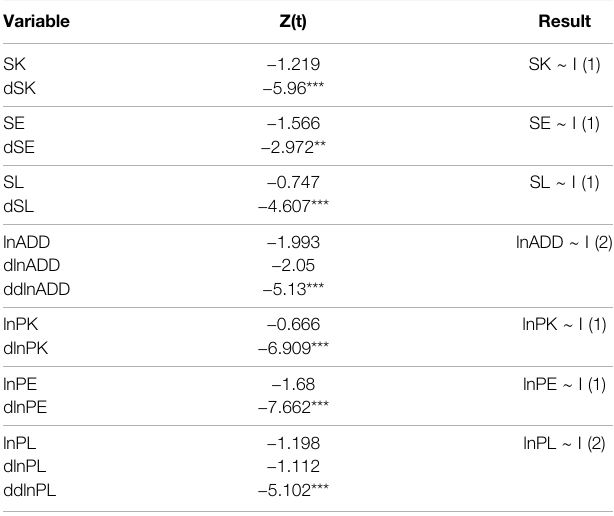
TABLE 2 | Unit root